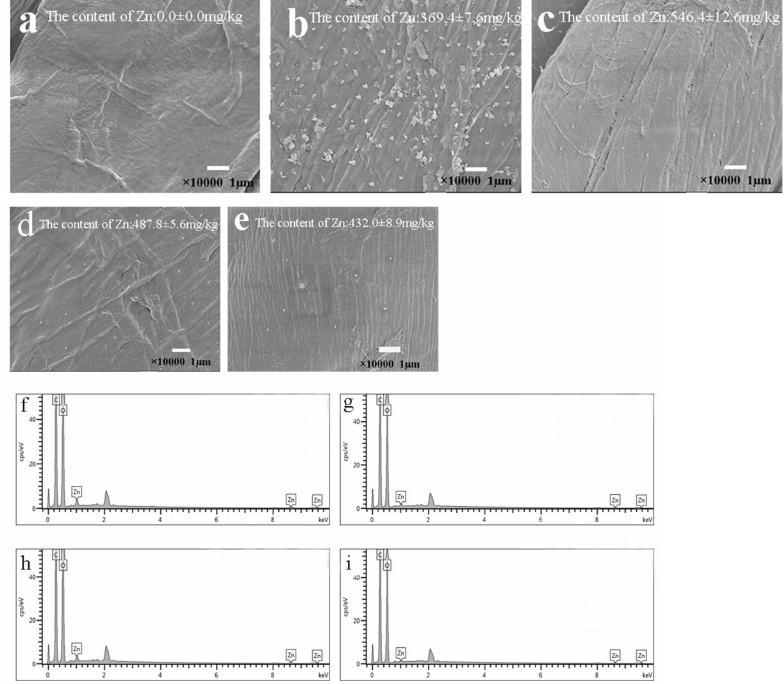
Figure 4. SEM images and Znelement contents of raw Cotton ( a ), ZnO/cotton ( b ),OA-ZnO/cotton ( c ), TA-ZnO/cotton ( d ), and SA-ZnO/cotton ( e ) and EDS spectra of ZnO/cotton ( f ), OA-ZnO/cotton ( g ), TA-ZnO/cotton ( h ) and SA-ZnO/cotton ( i